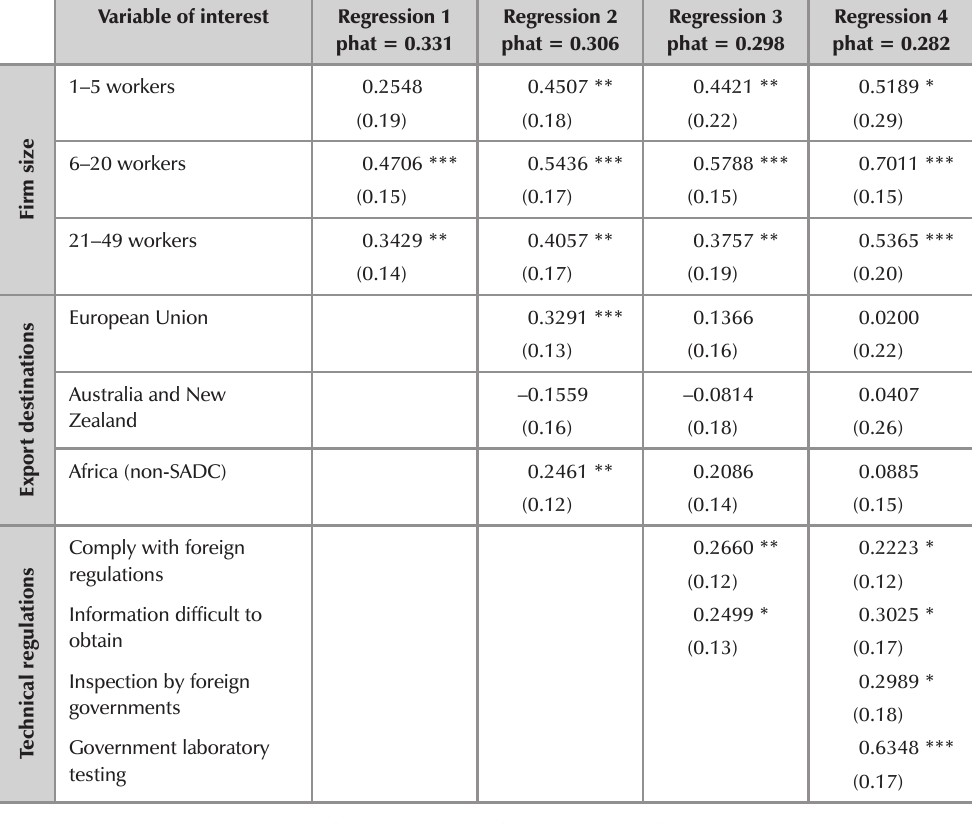
Selected marginal effects (at the mean) from logit regressions Variable of interest Regression